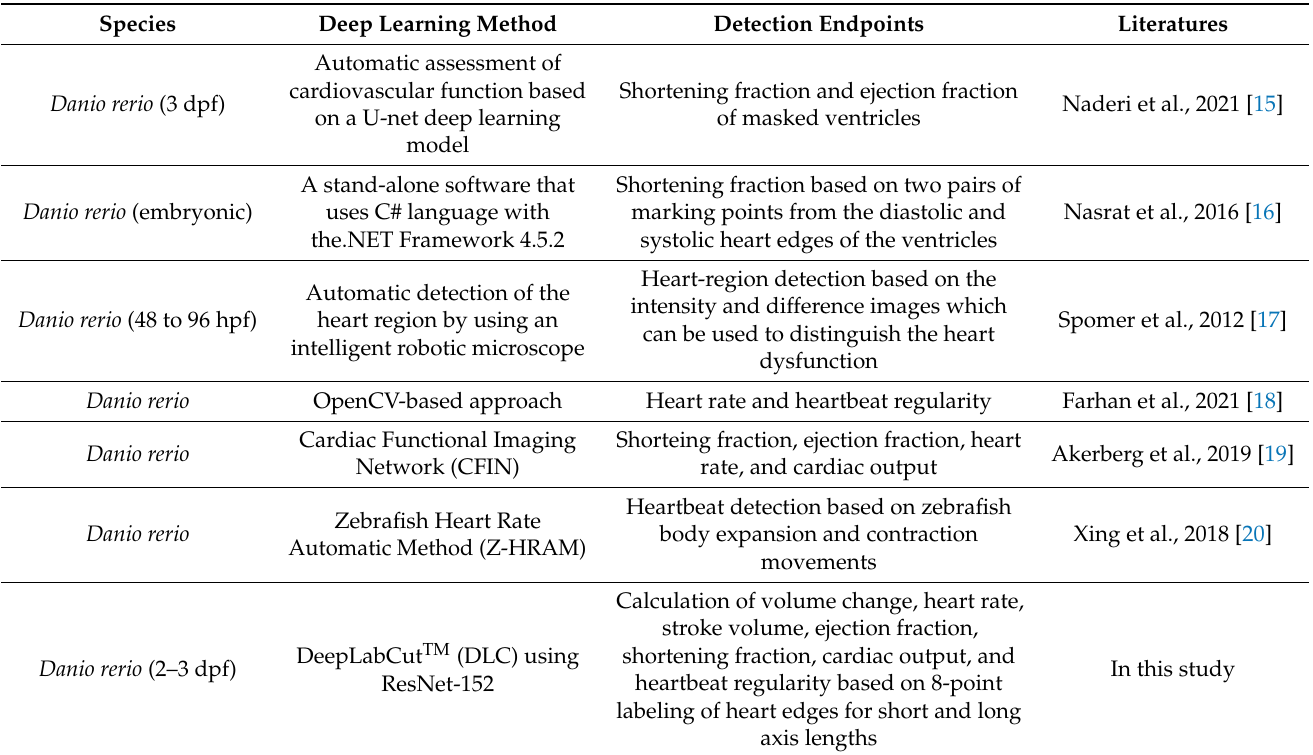
Table 2. Summary of deep learning-based methods and endpoints used to conduct cardiac physiology assessment in